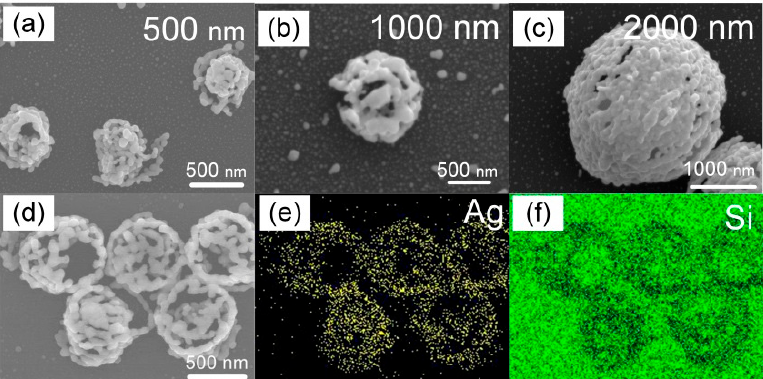
Figure 3. Morphology of silver nanocluster with different sizes. Silver nanocluster with sizes of ( a ) 500 nm, ( b ) 1000 nm, and ( c ) 2000 nm. ( d ) Magnified SEM image of five silver nanoclusters with a size of 500 nm, and corresponding EDS maps for ( e ) silver and ( f ) silicon.